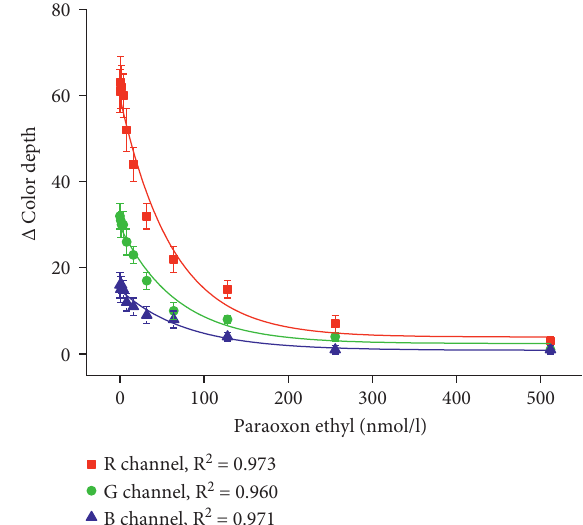
Figure 6: Calibration of colorimetric biosensor for paraoxon ethyl assay. The error bars indicate the standard error for five inde- pendent repeats ( n �